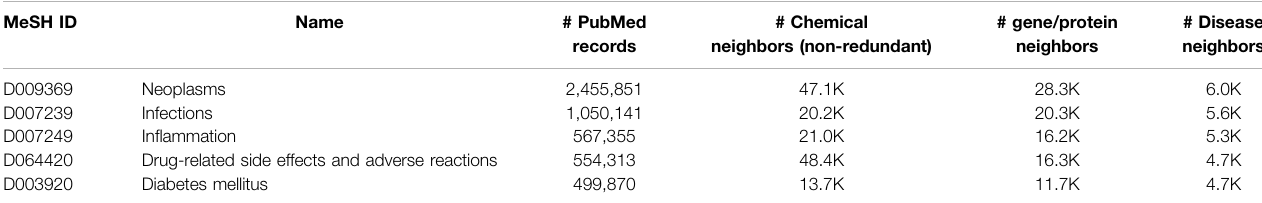
TABLE 5 | Top fi ve most mentioned diseases in PubMed records and the number of their chemical, gene/protein, and disease